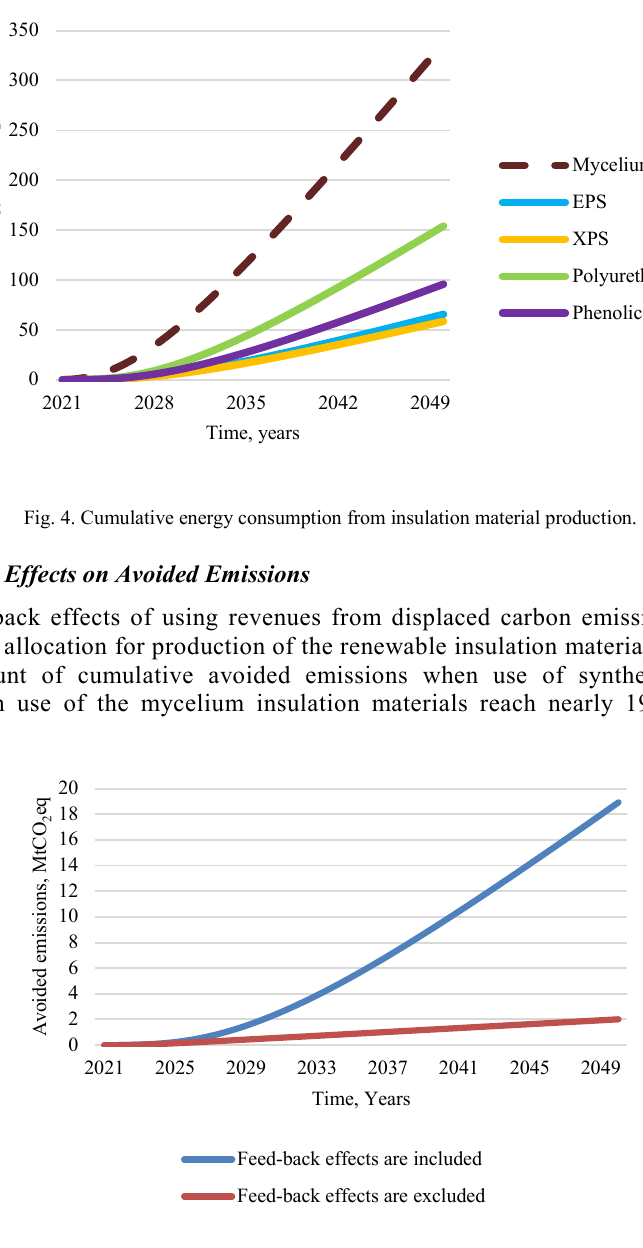
Fig. 5. Cumulative avoided GHG emissions when the emissions of the mycelium material is compared with the emissions resulting from phenolic foam, with feed-back effects included and